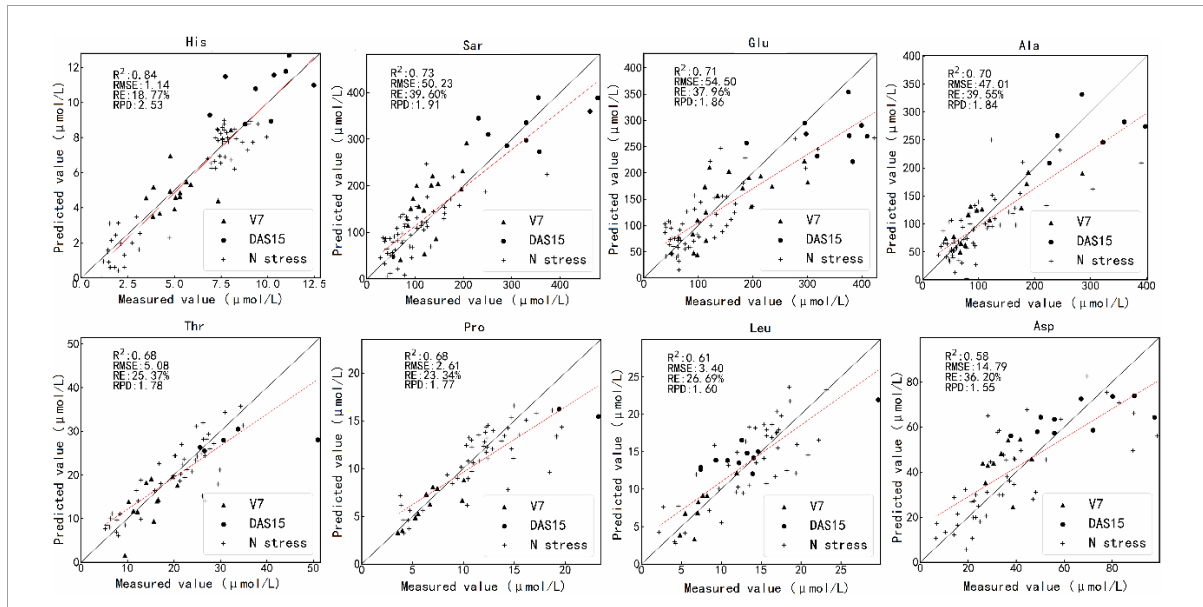
FIGURE5 Scatterplot of the measured value against the predicted value of the various amino acid contents by the optimal estimation method using test set. The caption above each subfigure is the name of the amino acid. V7 and DAS15 represent the samples obtained at two sampling times under different N treatments. N stress represents the samples obtained in the N starvation treatment experiment. V7 indicates that the maize is in the stage of the seventh fully unfolded leaf; DAS15 means the 15th day after maize